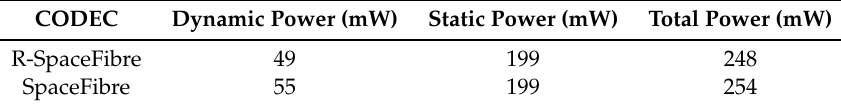
Table 3. R-SpaceFibre and SpaceFibre power